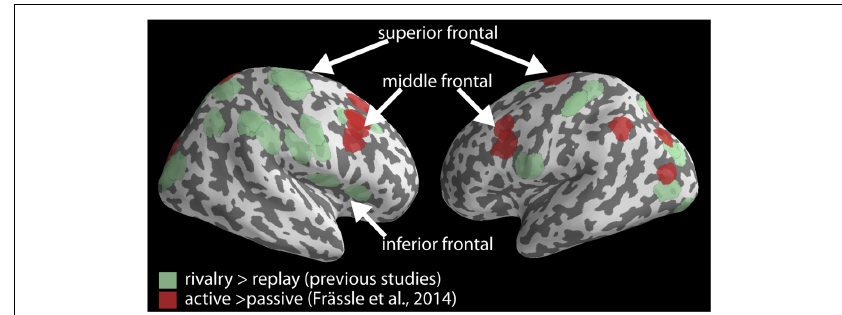
FIGURE 1 | Rivalry-related brain network. Locations reported to be more active in rivalry compared to instantaneous replay based on observer’s button presses in previous studies (green) are plotted together with locations that were less active during passive viewing than during the active report for the same comparison by Frässle et al. (red). Locations are plotted on a cortical surface reconstruction of the MNI brain using PySurfer (http://pysurfer.github.io). Coordinates of the locations in green are taken from the following studies: Lumer et al. (1998), Zaretskaya et al. (2010), Knapen et al. (2011), Frässle et al.